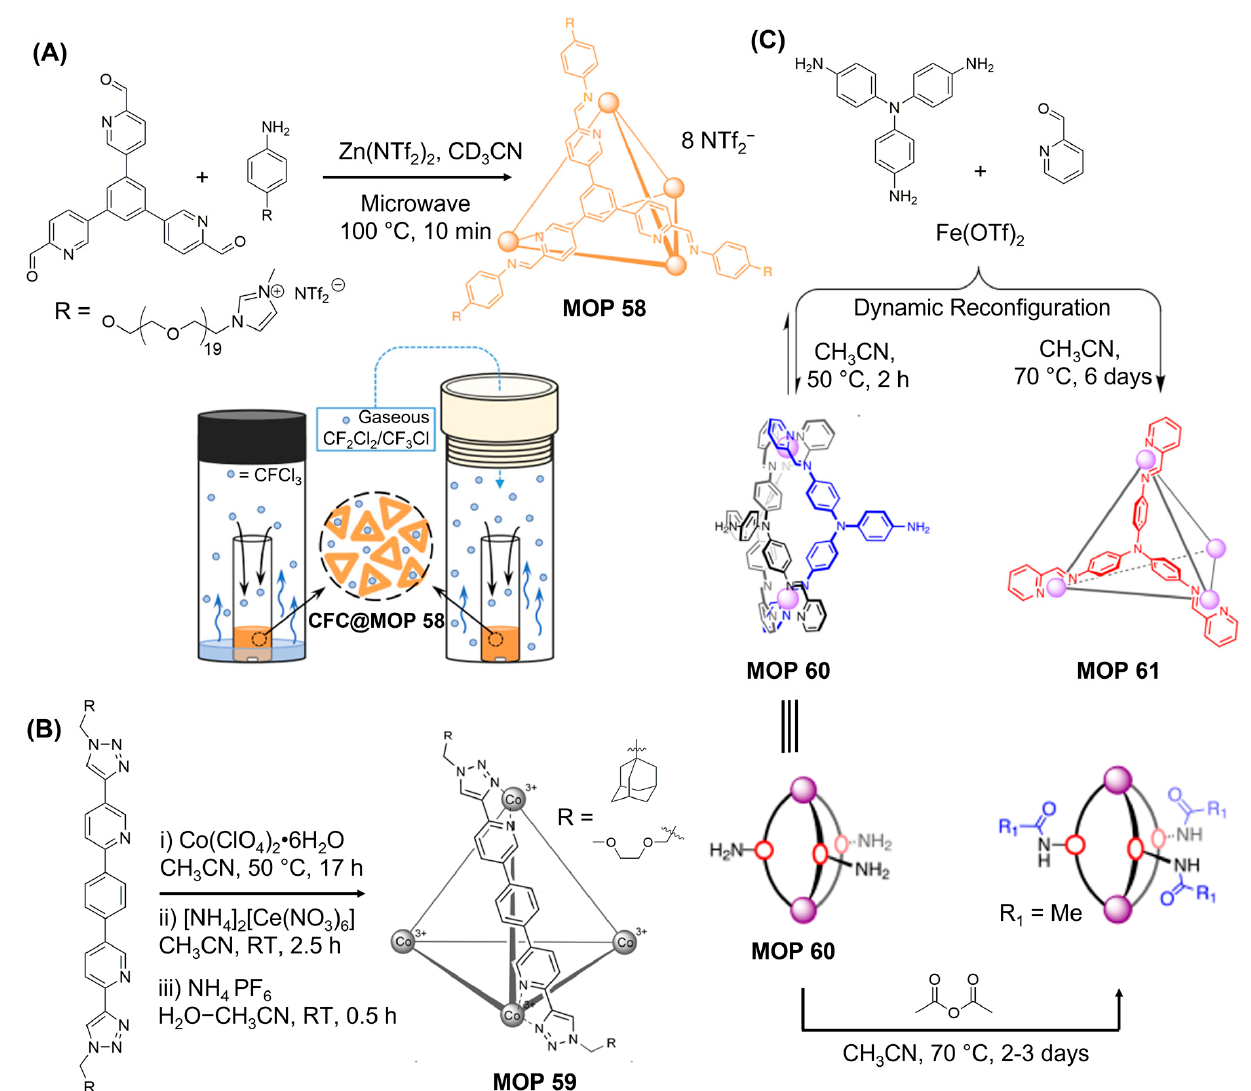
Figure 23. ( A ) Subcomponent self-assembly of MOP 58 from trisaldehyde, aniline and Zn(NTf 2 ) 2 in acetonitrile. When neat liquid MOP 58 was stirred under an atmosphere saturated with CFCl 3 , CF 2 Cl 2 or CF 3 Cl, the uptake of these gaseous guest molecules was observed. The samples were sub- sequently analyzed using solution-phase NMR techniques. ( B ) Synthesis of non-equilibrium Co(III) capsules following post-assembly oxidation of Co(II) tetrahedron to kinetically inert Co(III) tetrahe- dron using ceric ammonium nitrate. ( C ) Subcomponent self-assembly of tris(4-aminophenyl)amine with 2-formylpyridine and iron(II) triflate gave (i) kinetically stable Fe II2 L 3 helicate MOP 60 and (ii) thermodynamic product Fe II4 L 4 tetrahedron MOP 61. Covalent functionalization of helicate MOP 60 gave kinetically trapped helicate MOP. Reprinted by permission from Refs. [178–180]. Copyright